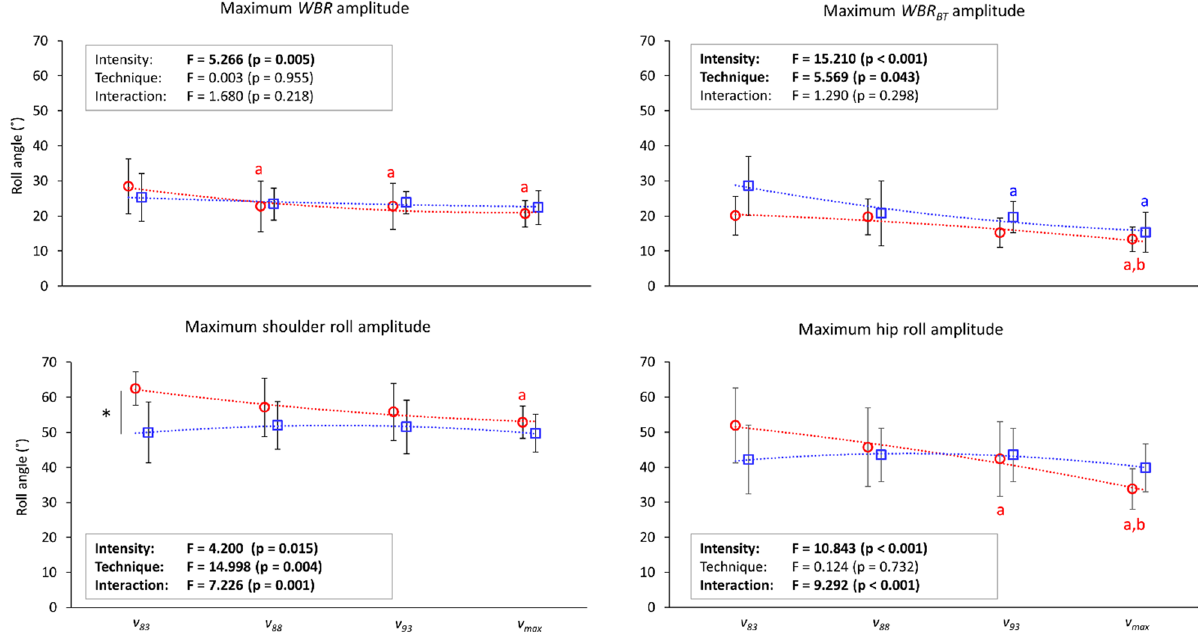
Figure 2. Maximum amplitudes of the whole-body roll ( WBR ), whole-body roll due to the buoyant torque ( WBR BT ), shoulder roll, and hip roll at 83, 88, 93, and 100% of the maximal velocity ( v 83 , v 88 , v 93 , and v max , respectively). The red circles are front crawl data, red squares are backstroke data, and the dot lines represent trend lines based on the observed results. Asterisks show differences between the techniques, and a, b, and c show differences from v 83 , v 88 , and v 93 ,